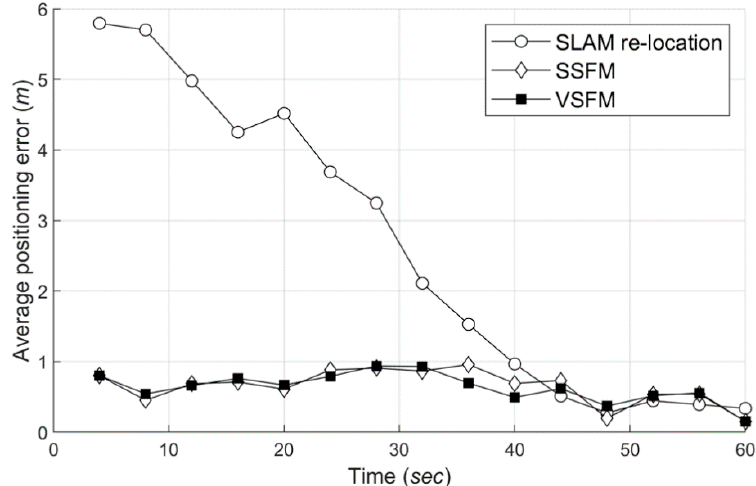
Figure 14. Positioning average error by the positioning algorithm (after recollection, # 852 training samples).